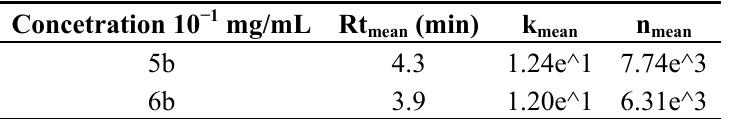
Table 1. The obtained values of Rt, k, n for the isocratic system acetonitrile/ammonium formate buffer (30:70 v/v, pH =